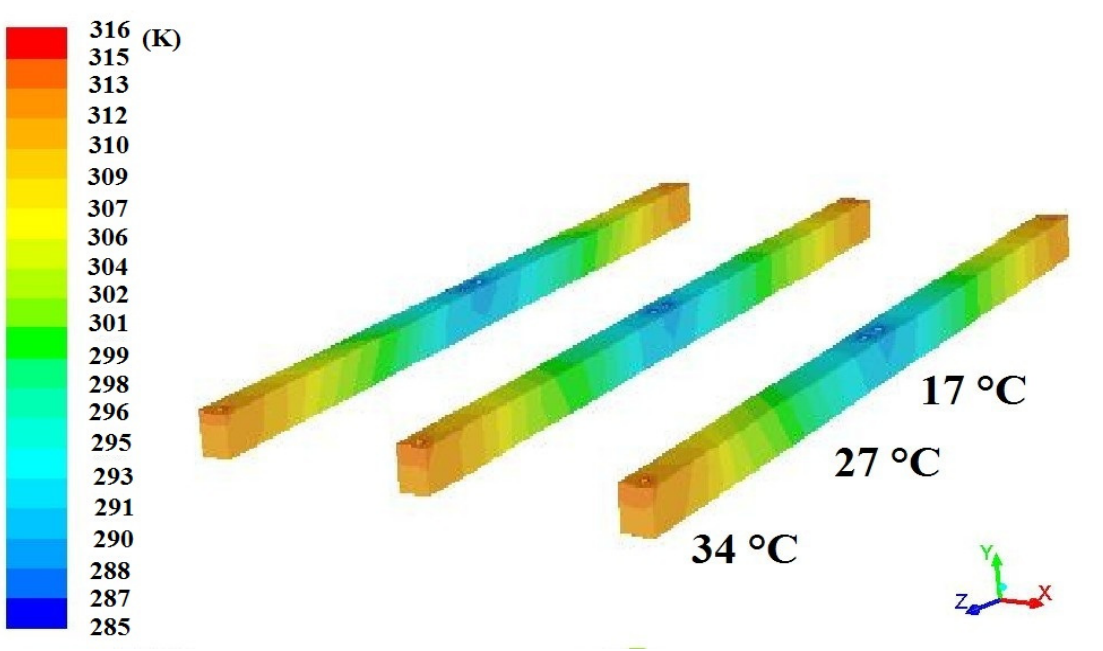
Figure 10. Temperature distribution (K) in the blocks of the rock bed heating system during the storage phase at noon (273 K = 0 °C).